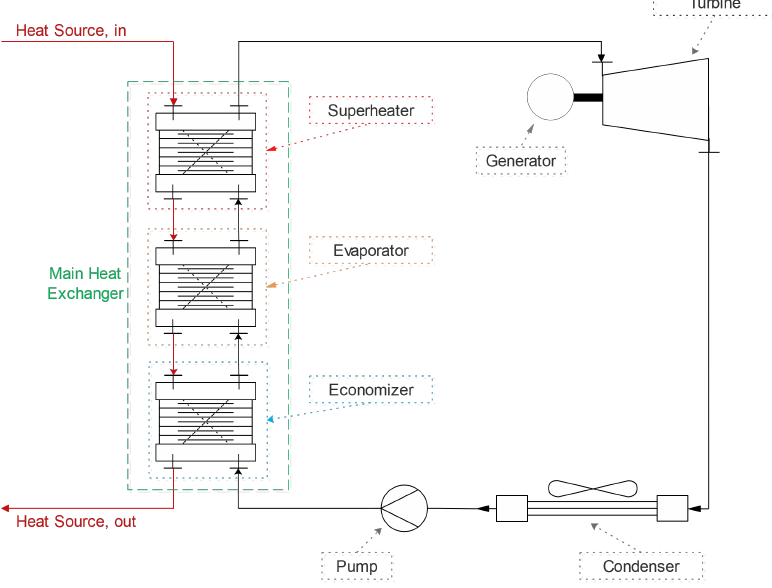
Figure 1. The SRC plant layout equipped with the air-cooled